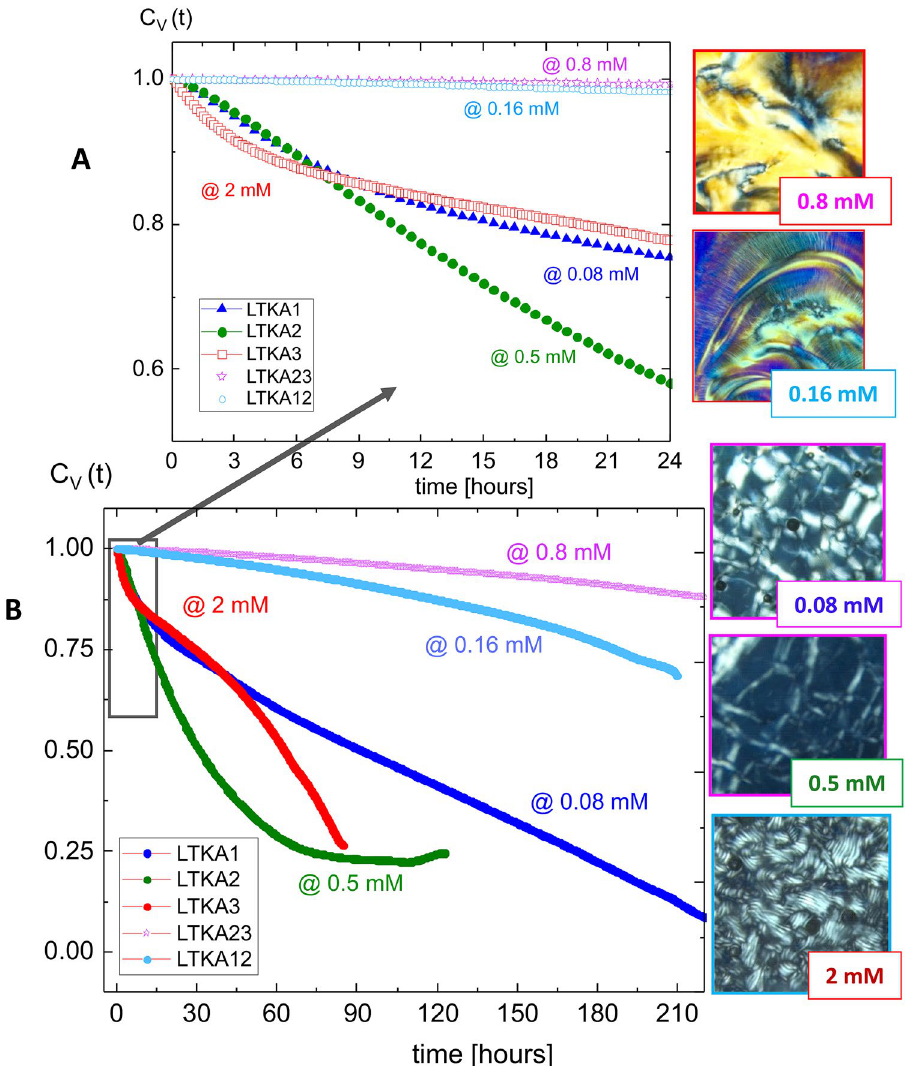
Figure 4. The results of long-time kinetic arrests (LTKAs), obtained by image-time correlation and the final state of the equilibrium phase for varying the ionic strengths: ( A ) for a shorter time duration, and ( B ) for longer- time correlations to reach the corresponding phases, which are the glass (in 0.16–0.8 mM), X-pattern (in 0.5 mM), the mixed state of X-pattern and the helical domains (in 0.08 mM), and N–N* (N-star) (in 2 mM). The results of image-time correlations for the orientation textures are shown as a function of ionic strengths. Slow decays are carried out for two ionic strengths in the glass state, in LTKA12 and LTKA23. According to the result, LTKA23 turned out to slow down even faster than LTKA12. However, near the glass, the X-pattern exists with mixed states of the helical domains (in 0.08 mM) and occasional voids. LTKA1, LTKA2, and LTKA3 are all decayed to below a value of 0.25 in correlations. Note here that concentrations of above 4 in ionic strength are higher than in the case of 2 mM, thus it also decays faster compared to the